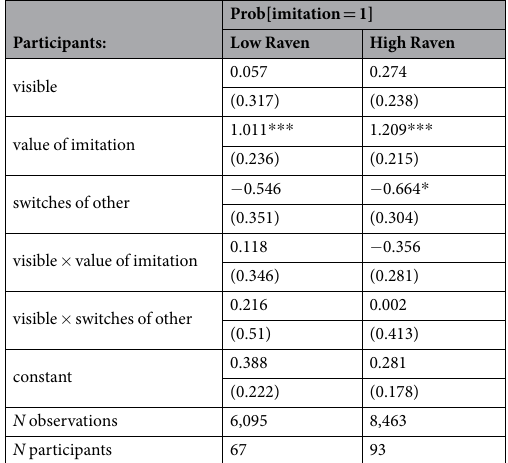
Table 1. Random effects logit regression of imitation choices in Experiment 2. The dependent variable imitation is 1 when a participant chooses the same action as the demonstrator (see Appendix A for the description of all variables used in the analyses). The independent variable visible is 1 if the Raven score of the demonstrator is known to participants. The variable value of imitation tracks the average payoff obtained from choosing the same action as the demonstrator in the last 10 times she was observed. The variable switches of other is equal to the number of switches between actions that the demonstrator made in the last 10 times her actions were observed. Standard errors in parentheses. * p < 0.05; ** p < 0.01; *** p <